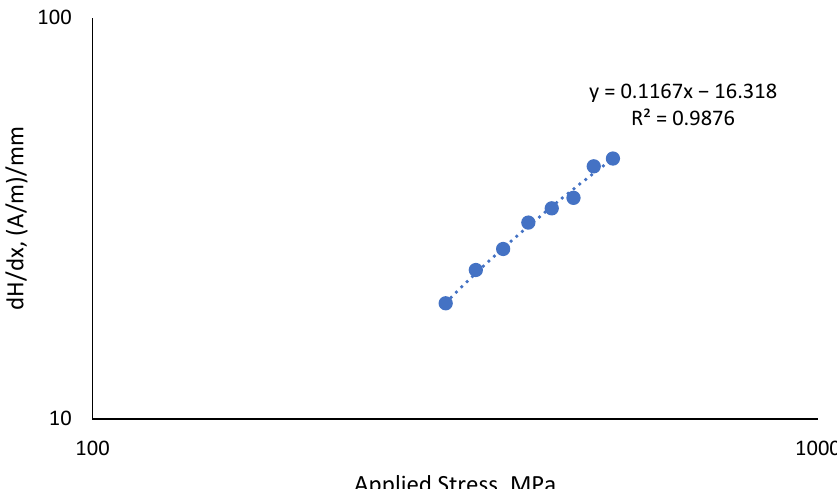
Figure 11. Correlation of dH(y)/dx value with all uniaxial applied stresses.